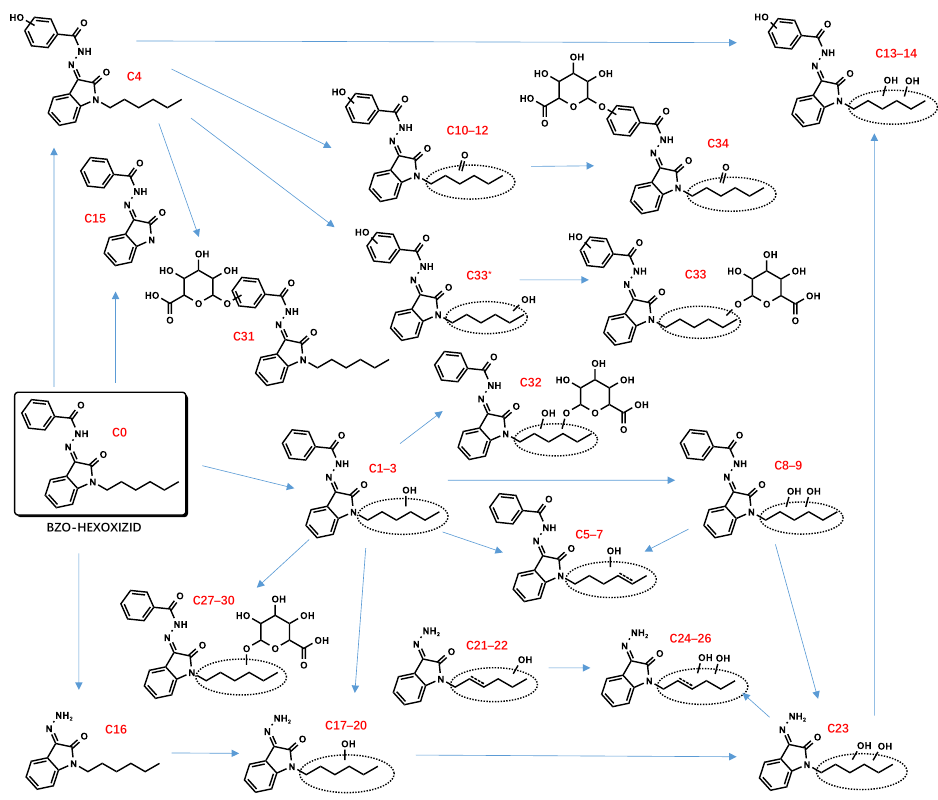
Figure 5. Proposed metabolic pathway of BZO-HEXOXIZID.